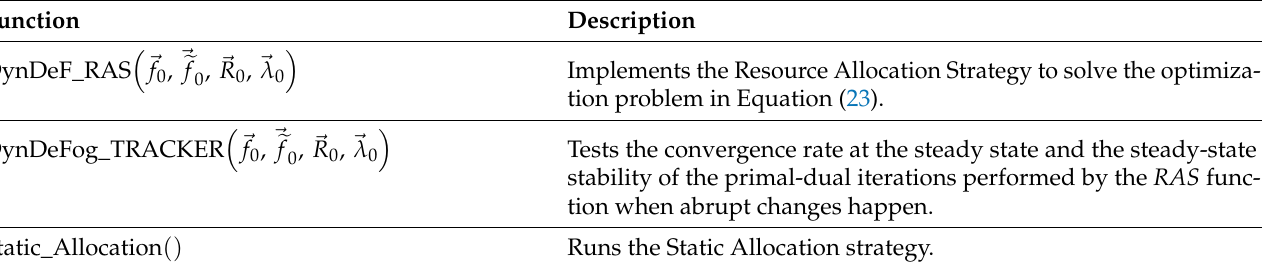
Table 2. Main functions implemented by DeepFogSim . Description